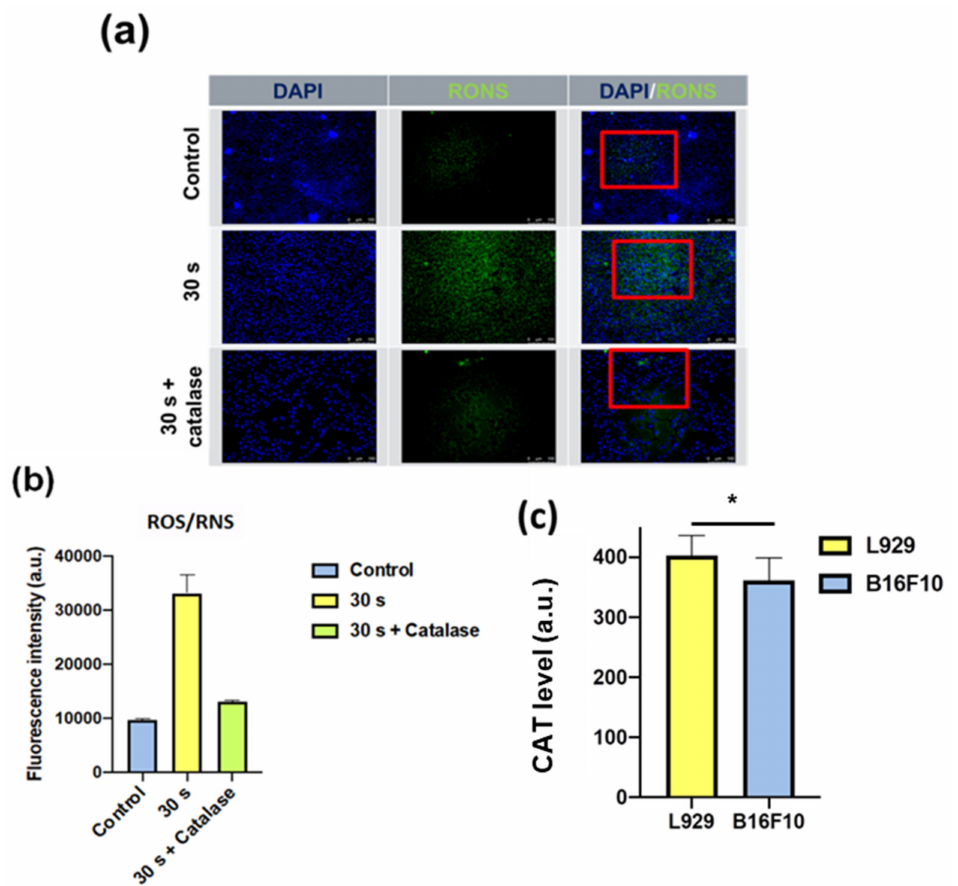
Figure 7. Cellular (B16F10 cells) reactive oxygen and nitrogen species (RONS) generation. ( a ) Quali- tative and ( b ) quantitative RONS data indicating that cells that received catalase (CAT) could inhibit RONS generation after cold atmospheric plasma (CAP) treatment compared to the CAP-treated group (without CAT). ( c ) Cellular CAT levels were determined by immunofluorescence. (* p <